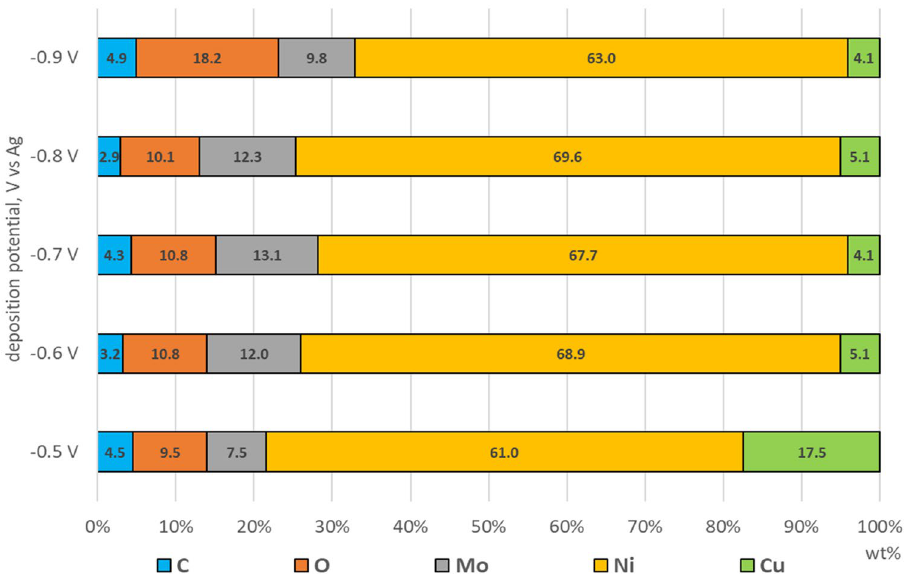
Figure 5. Results of EDS analysis performed on samples with Ni–Mo alloy coatings deposited from DES + 0.2 mol dm −3 NiCl 2 + 0.01 mol dm −3 (NH 4 ) 6 Mo 7 O 24 at − 0.5, − 0.6, − 0.7, − 0.8, − 0.9 V vs. Ag for 60 min at 50 °C.